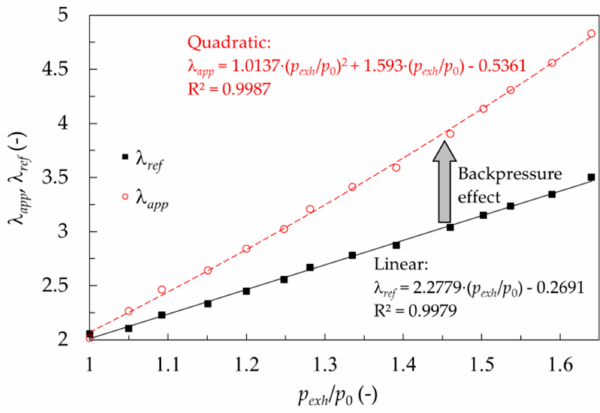
Figure 5. Comparison of λ app and λ ref for non-EGR conditions, constant fueling rate of 15 mg /